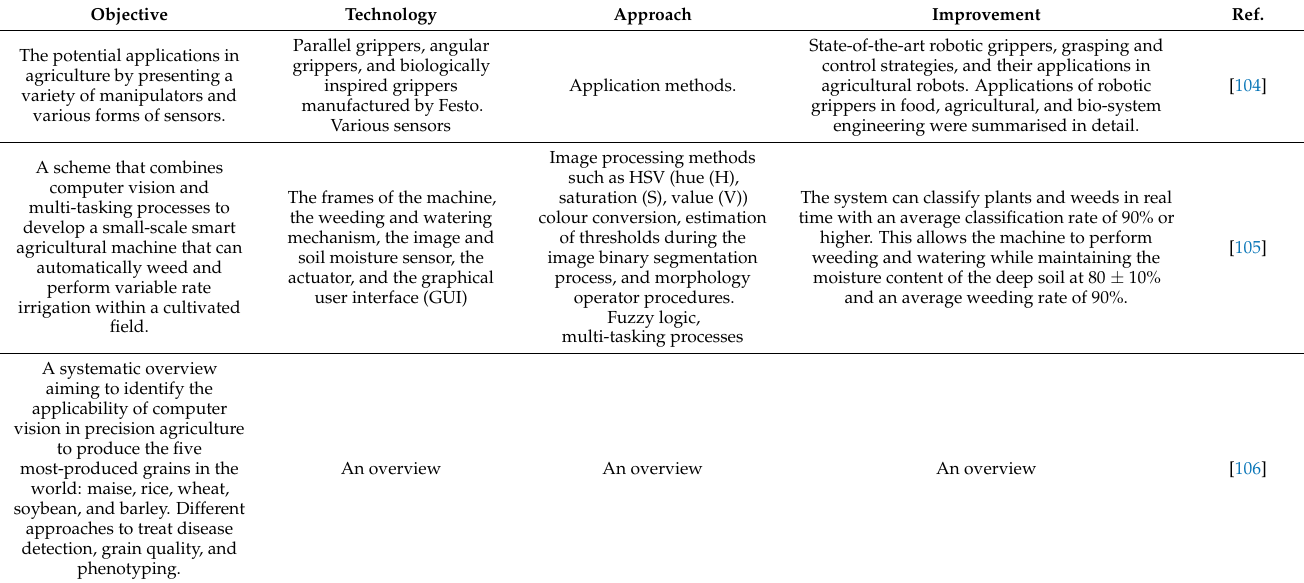
Table 7. Research focused on agricultural